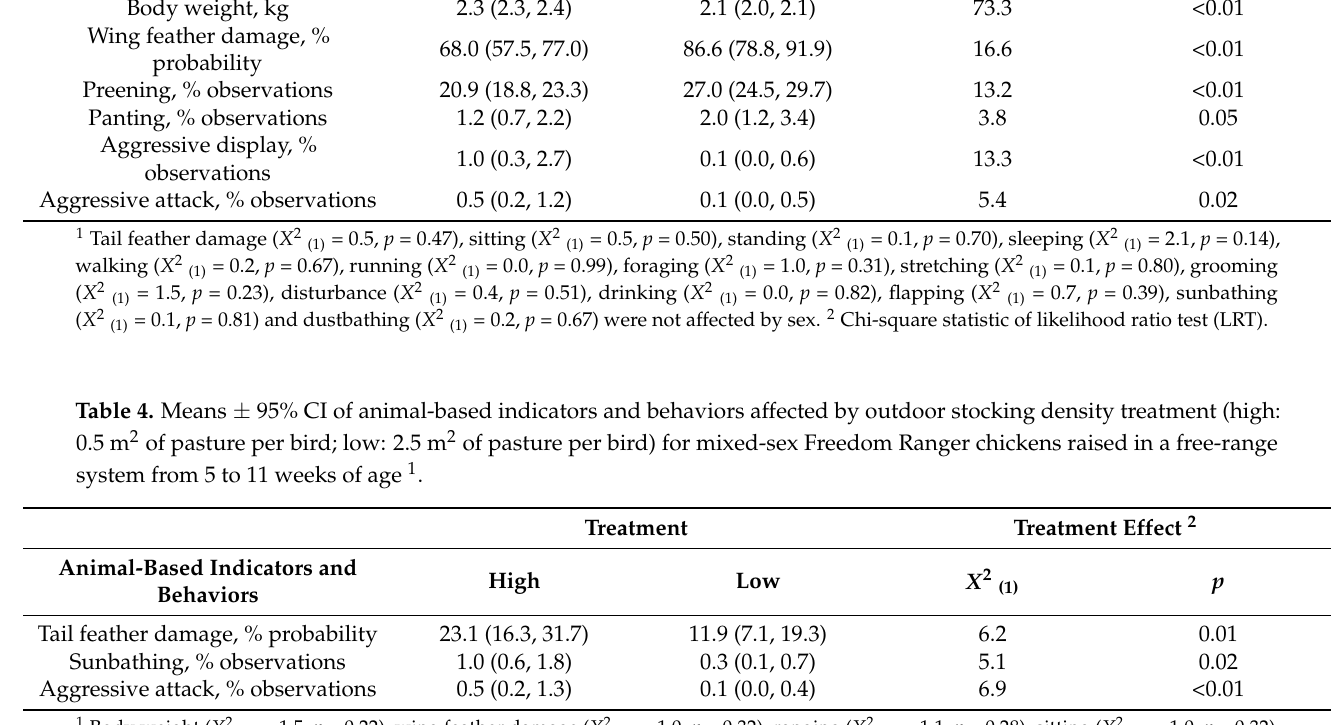
dustbathing ( X 2 (1) = 0.1, p = 0.82) were not affected by treatment. Stretching ( X 2 (1) = 18.5, p < 0.01) and panting ( X 2 (1) = 16.6, p < 0.01) were affected by the treatment × age interaction effect. 2 Chi-square statistic of likelihood ratio test